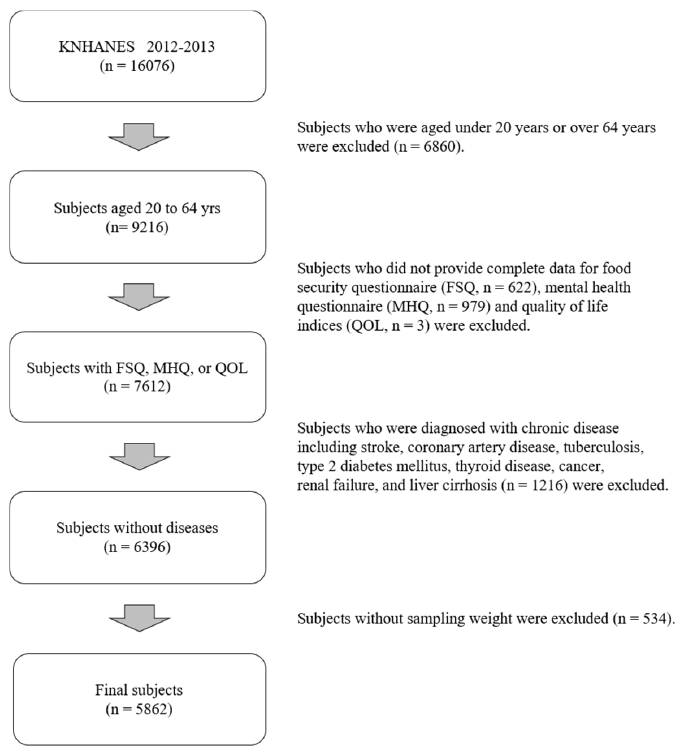
Figure 1. Flowchart of study population. FSQ: food security questionnaire; MHQ: metal health questionnaire; QOL: quality of life.